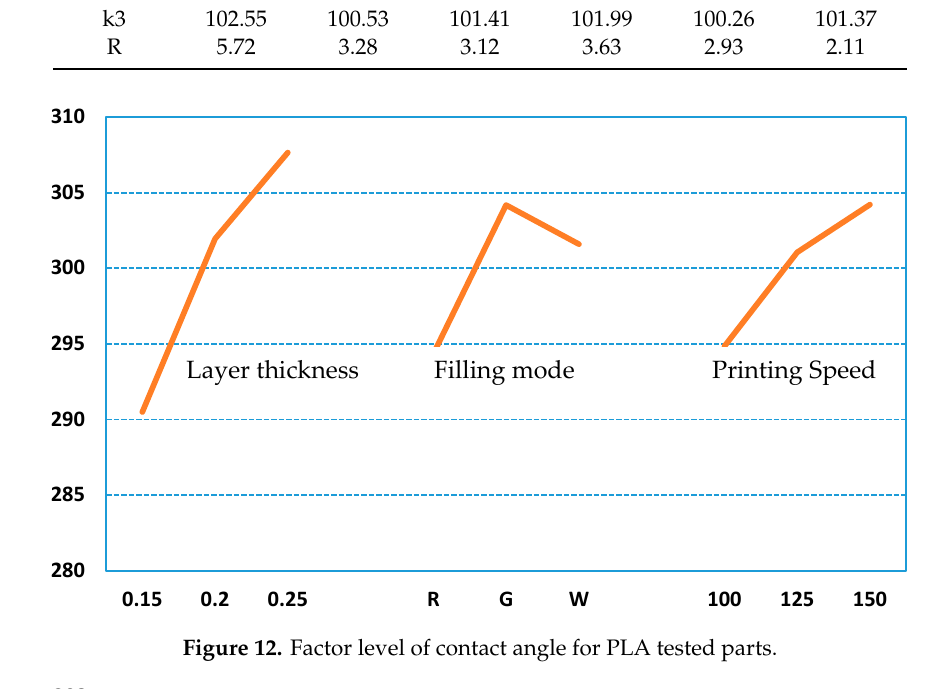
Figure 12. Factor level of contact angle for PLA tested parts .